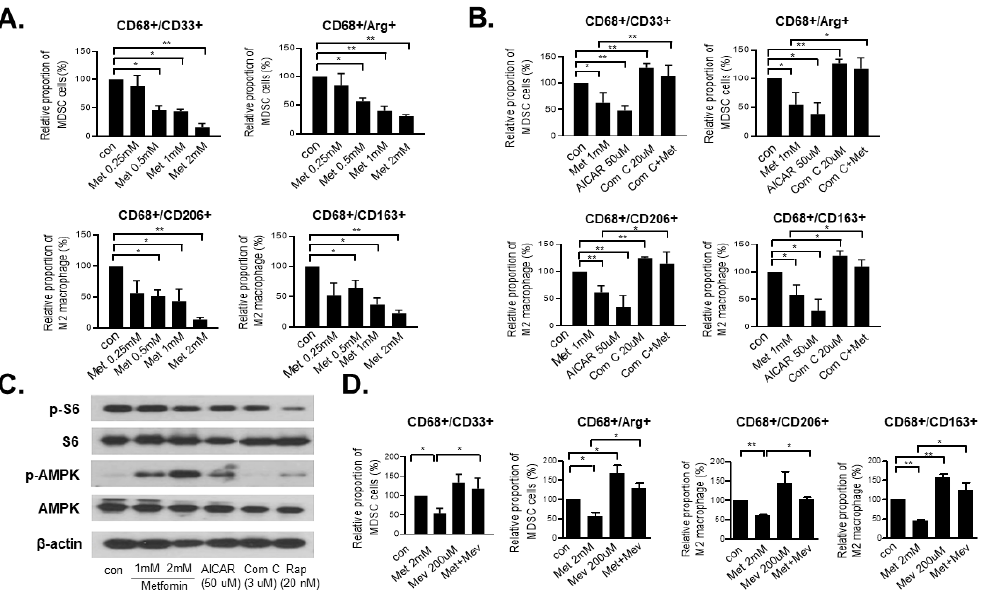
Figure 1. Metformin, an AMPK regulator, and mevalonate modulate the fractions of MDSCs and M1/M2 macrophages. ( A ) THP-1 cells were treated with 0.25 to 2 mM metformin in a dose-dependent manner for 48 h., and ( B ) THP-1 cells were treated with 1 mM metformin, 50 μM AICAR, 20 μM Comp C and a combination of Comp C and metformin for 48 h. Next, flow cytometry analyses were performed using the markers of MDSCs (CD68 + CD33 + and CD68 + Arg-1 + ), and M2 macrophages (CD68 + CD206 + and CD68 + CD163 + ). Data are expressed as the means ± standard errors of the four different experiments; * p < 0.05, ** p < 0.005. ( C ) In Western blot analysis, the expressions of phosphorylated S6 and phosphorylated AMPK were analyzed after 48 h of treatment with the control vehicle or 1 mM and 2 mM metformin, 50 μM AICAR, 3 μM Comp C and 20 nM rapamycin in THP-1 cells. ( D ) THP-1 cells were treated with 2 mM metformin with or without 200 μM mevalonate. Next, the expression levels of MDSC (CD33 + /CD68 + and Arg-1 + /CD68 + ) and M2 macrophages (CD206 + /CD68 + and CD163 + /CD68 + ) markers were analyzed by flow cytometry. Data are expressed as means ± standard errors of the three different experiments; * p < 0.05, ** p < 0.005.